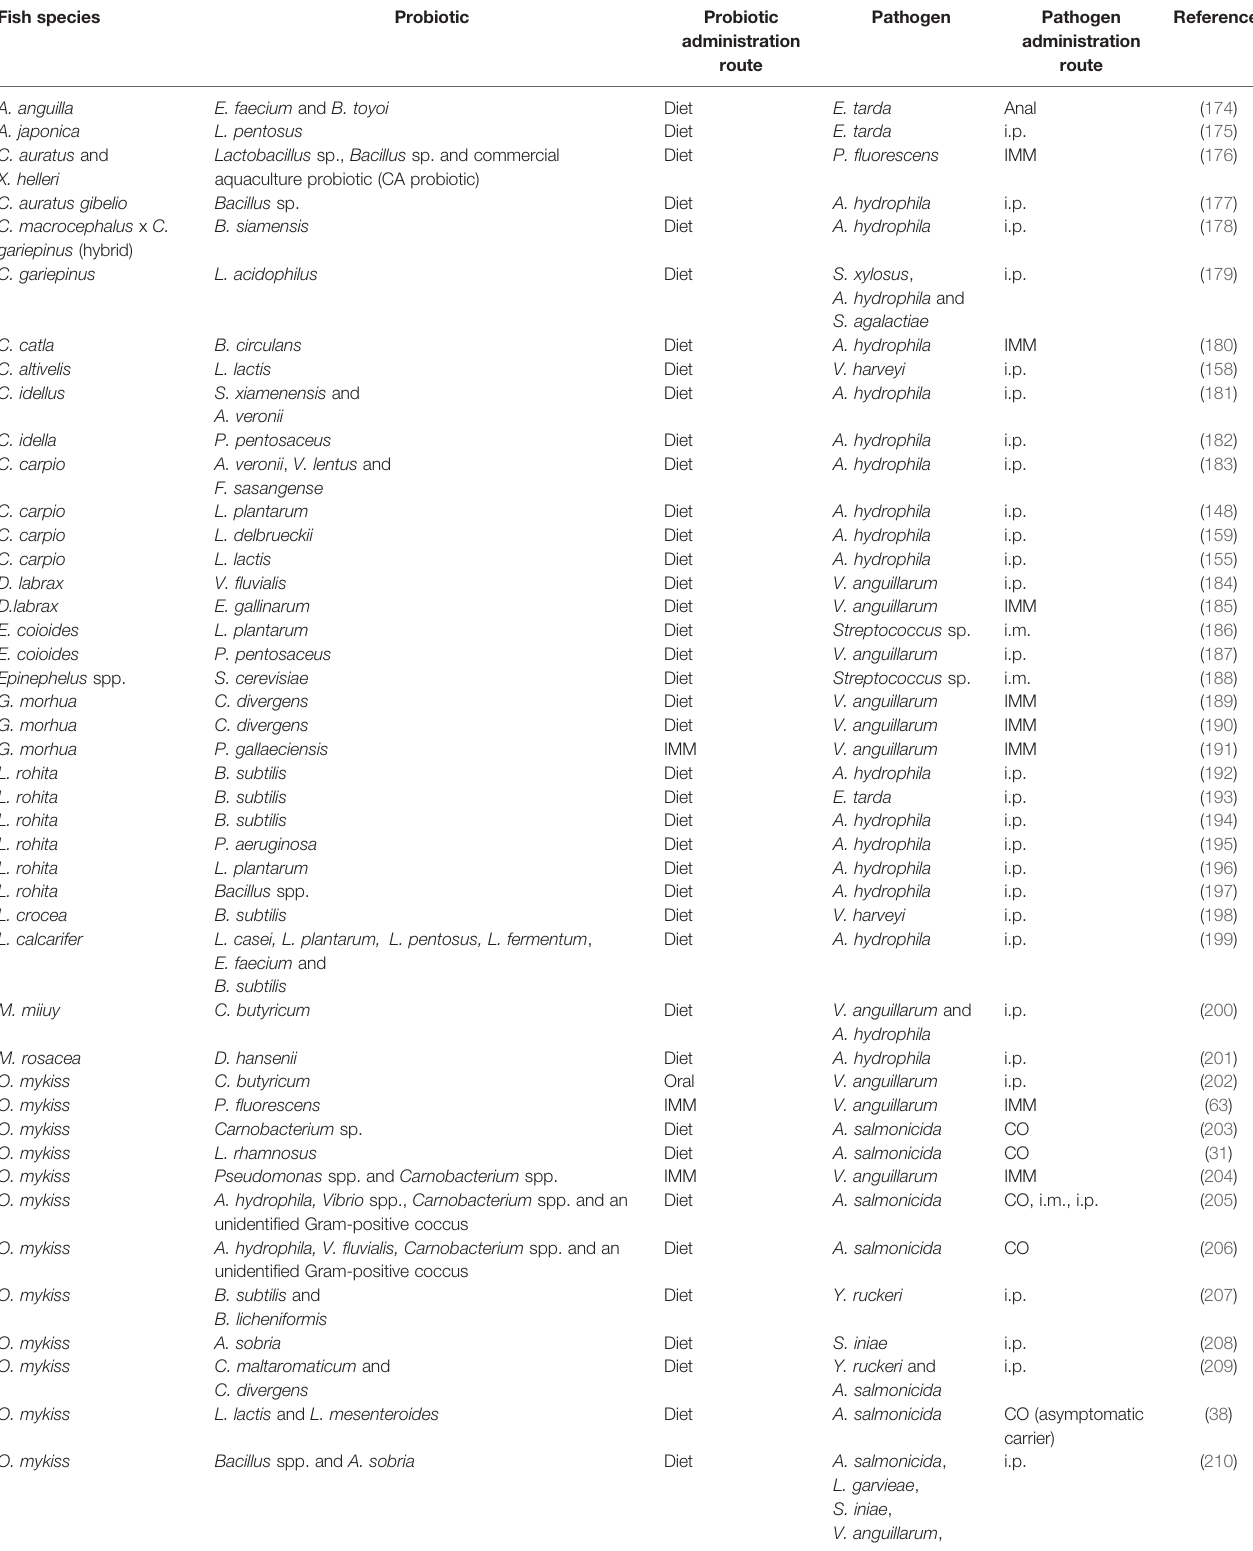
TABLE 1 | Probiotics assayed in vivo in aquacultured species which have shown to confer signi fi cant resistance against bacterial pathogens. Fish species